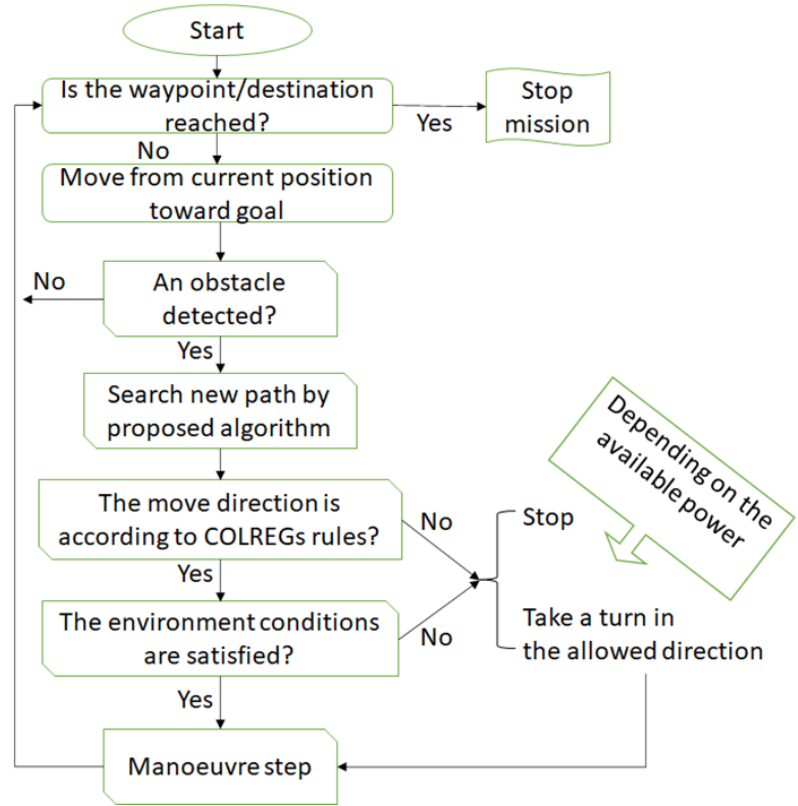
Figure 4. Flow schematic of the proposed path planning system.